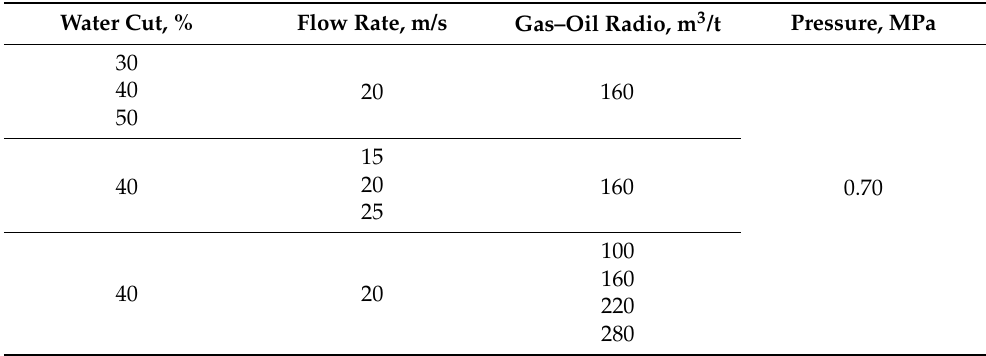
Table 2. Parameters for the simulated calculation. Water Cut, % Flow Rate,